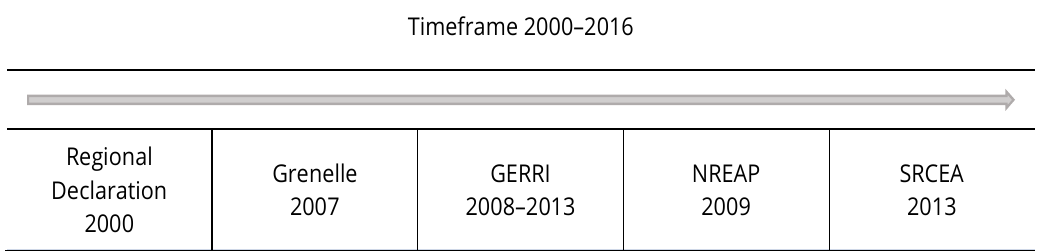
Table 2. Key actors within Reunion Island’s EGC